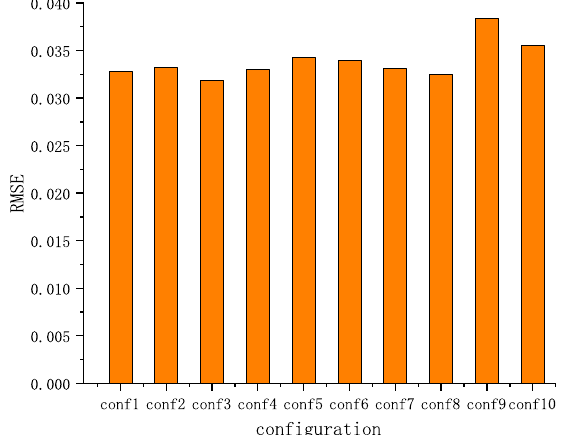
Figure 9. Root-mean-squared error (RMSE) versus configurations.